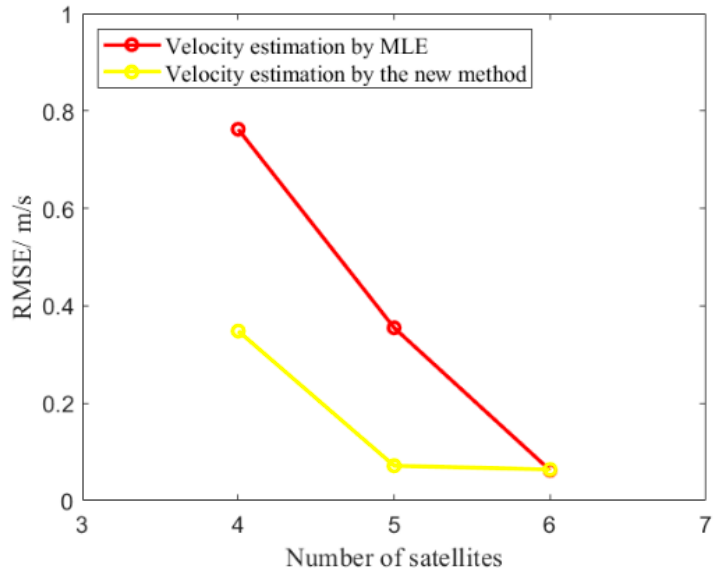
Figure 10. Velocity estimation error versus the satellite number.